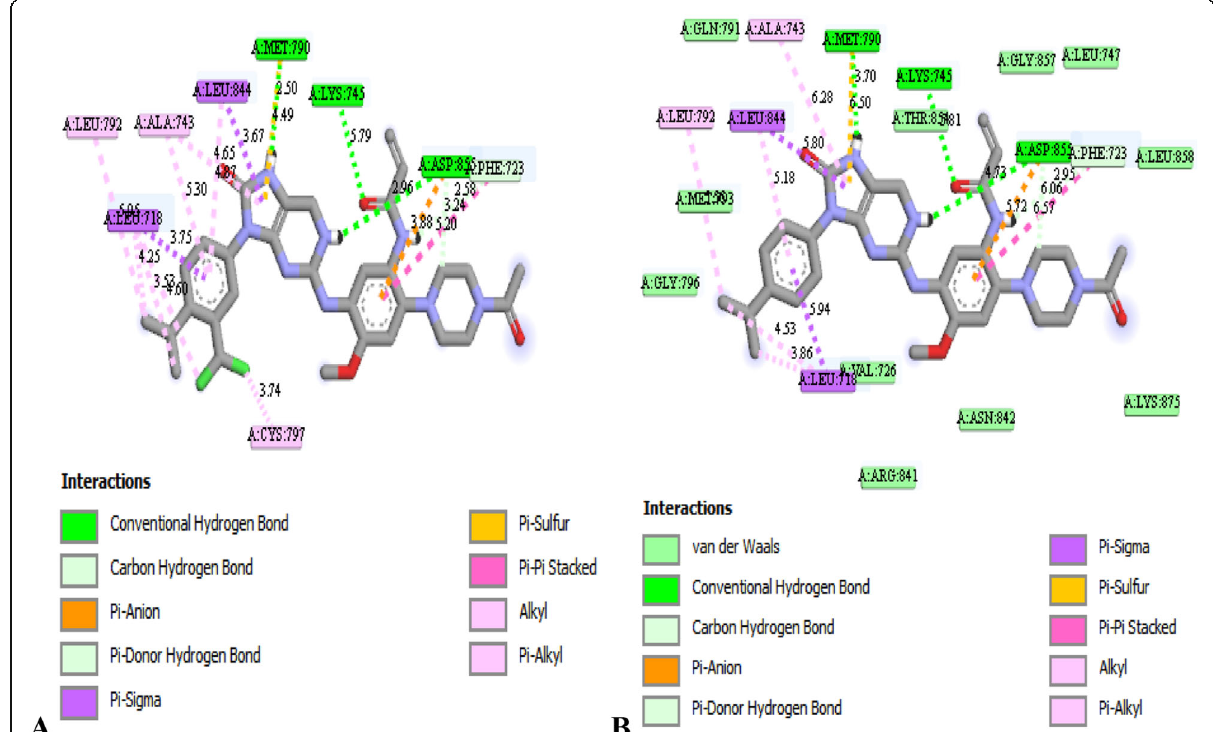
Fig. 7 2D-structure of designed compound ( a) D3 and ( b ) D5 in complex with EGFR enzyme